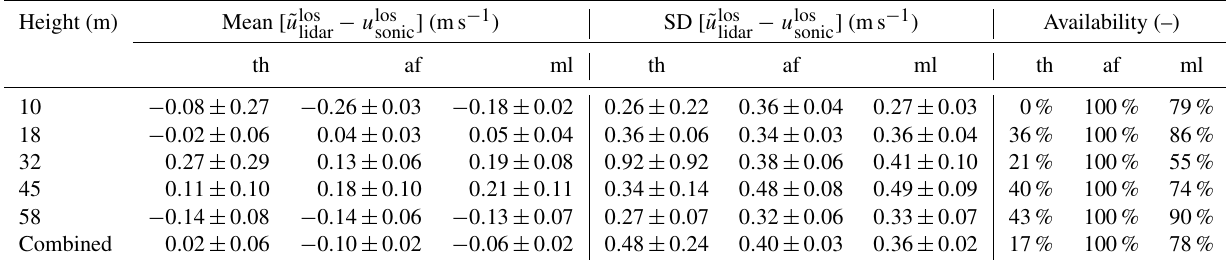
Table 6. Performance of lidar retrieval techniques versus sonic anemometer for waked cases with solid interference. The abbreviations are threshold (th), advanced filter (af), and machine learning (ml). SD refers to standard deviation. Height